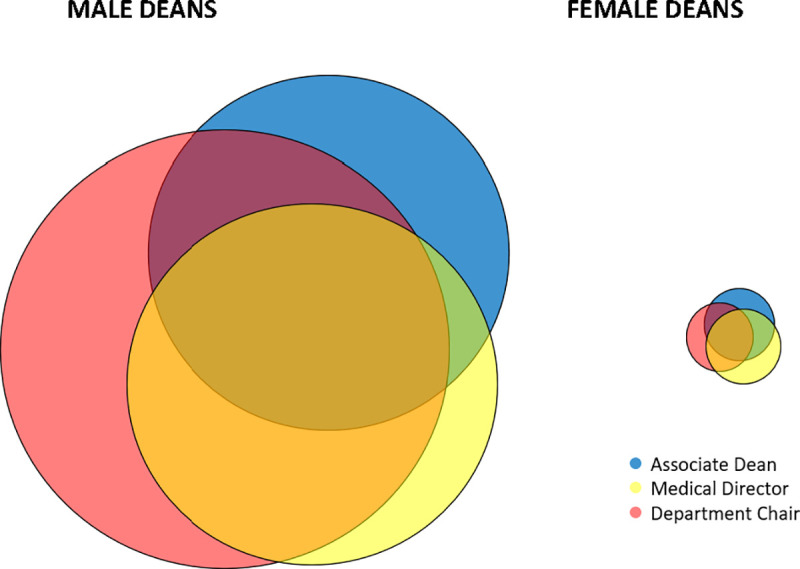
Leadership experience prior to becoming Dean by gender.This figure depicts data from a study of Deans of U.S. Schools of Medicine (95 of 153 total whose CVs were available for review). The three most commonly held leadership positions prior to an individual’s first appointment as Dean of Medicine were Department Chair (73%), Associate Dean (51%), and Medical Director (51%). These area-proportional Venn diagrams, depict prior experience by gender.